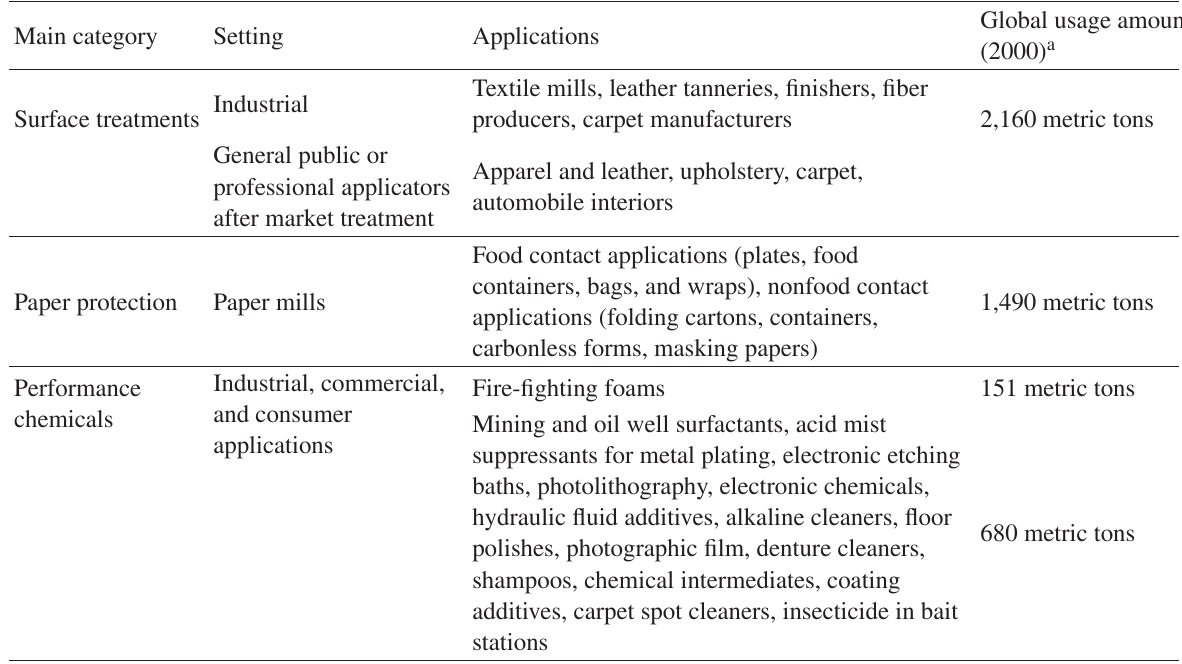
TABLE 1: Global usage amounts of PFOS-related substances in diverse settings and per use